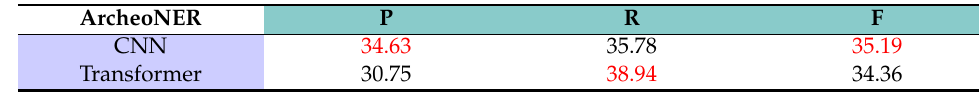
Table 2. Comparison of the results of the two ArcheoNER models.